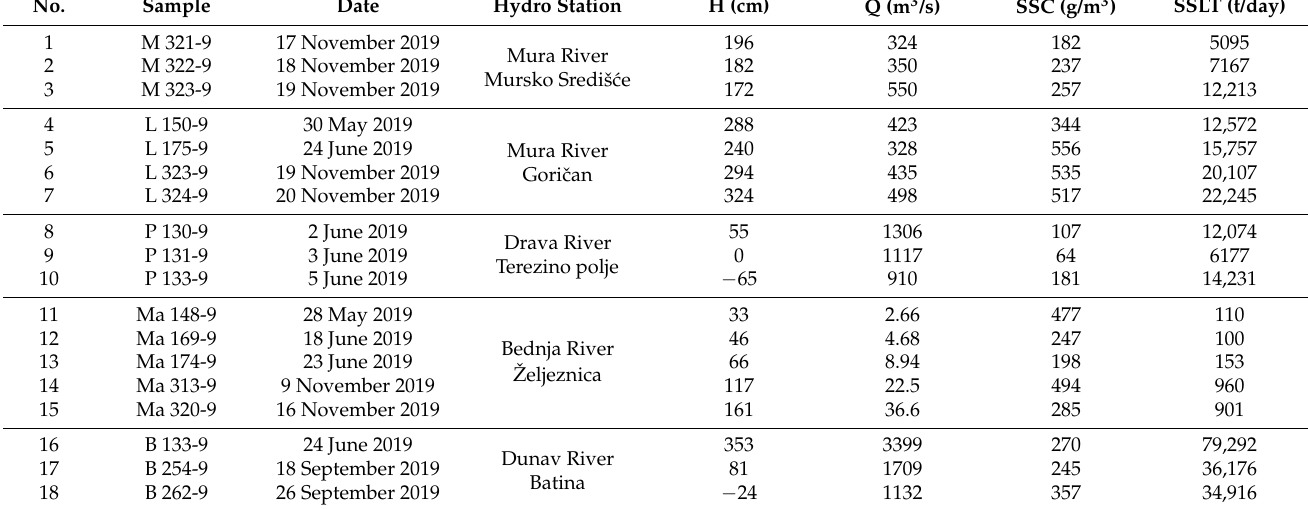
Table 2. List of locations with main hydrological